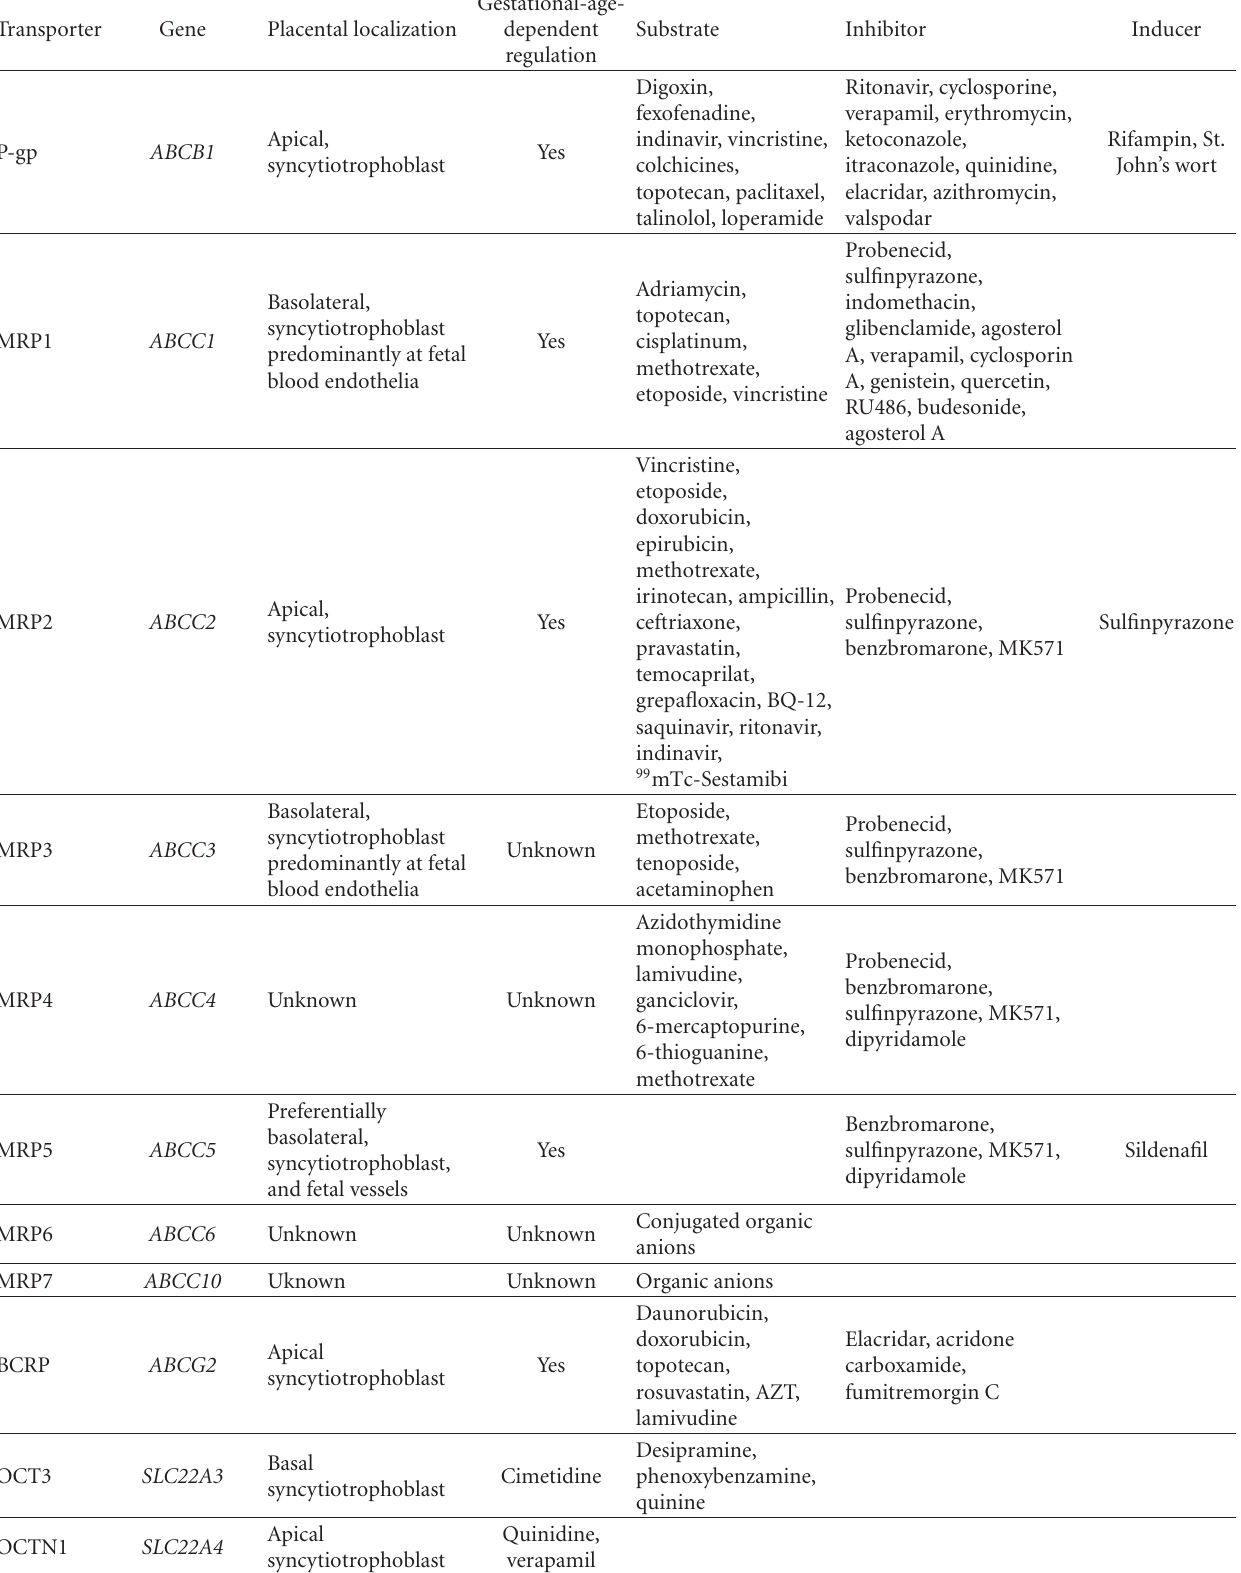
Table 3: Major ABC drug e ffl ux transporters, their placental localization, and substrates.